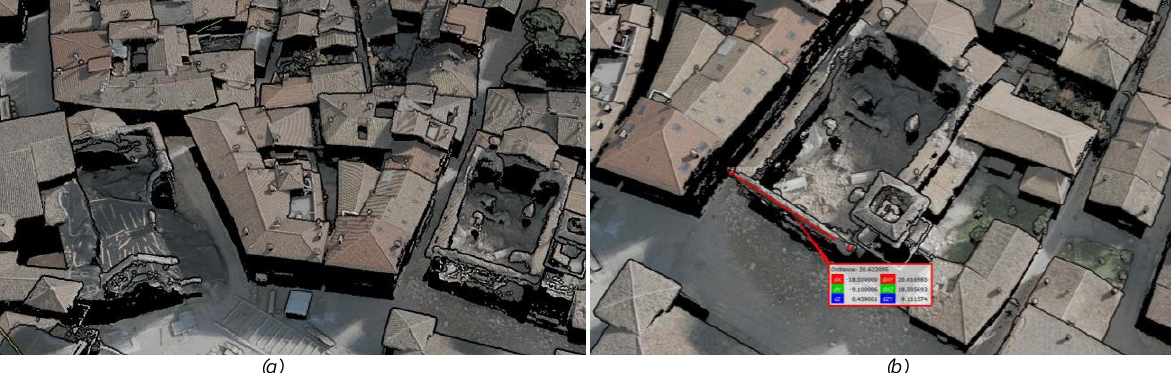
Figure 8. Shaded 3D point cloud of Norcia with RGB information